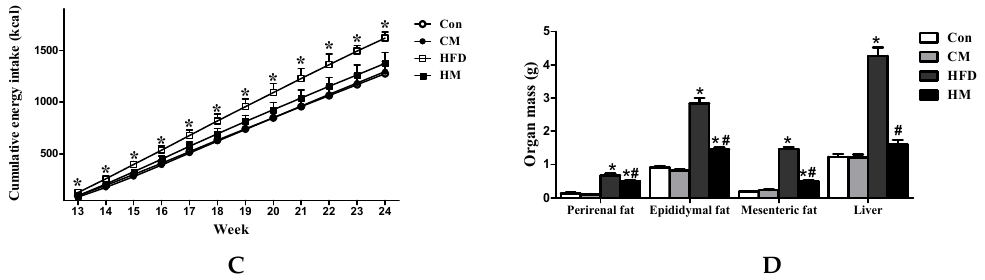
Figure 1. Effects of myricetin on body weight, cumulative food intake and energy intake, and organ mass of mice fed with a high-fat diet. ( A ) Body weight; ( B ) cumulative food intake; ( C ) cumulative energy intake; and ( D ) perirenal, epididymal, and mesenteric fat and liver weight. Values were presented as mean ± SEM ( n = 8). Con, control diet; CM, control diet with additional 0.12% myricetin; HFD, high-fat diet; HM, high-fat diet with additional 0.12% myricetin. * p < 0.05 vs. the Con group; # p < 0.05 vs. the HFD group.